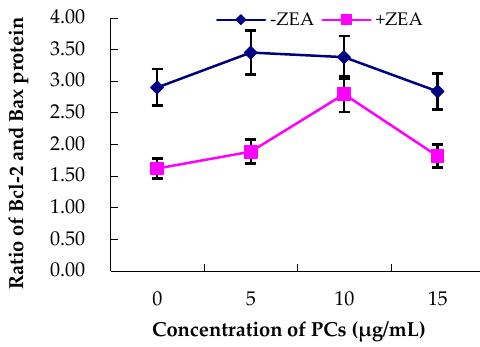
Figure 12. Effects of proanthocyanidins (PCs) on zearalenone (ZEA)-induced ratio of Bcl-2/Bax. The ratio of Bcl-2/Bax was higher when the concentration of PCs was 10 μg/mL in the co-treated PC/ZEA group. 3.6. Expression of the mRNA and Protein Related to ERS-Induced Apoptosis Pathway in MODE-K Cells As shown in Figures 13 – 16, compared with control group, in the ZEA group, the expressions of mRNA and CHOP, GRP78, JNK, p-JNK, and caspase-12 proteins all increased with significant differences ( p < 0.01). Compared with the control group, mRNA and protein expressions of GRP78 in all PC groups had no significant differences ( p > 0.05); the expressions of JNK and p-JNK proteins in the PCs15 group significantly increased ( p < 0.05), whereas JNK and p-JNK protein expressions did not increase in the PCs5 group ( p > 0.05). The mRNA and protein expressions of caspase-12 in the PCs5 group decreased ( p < 0.05), and in the PCs10 group they did not increase ( p > 0.05), whereas in